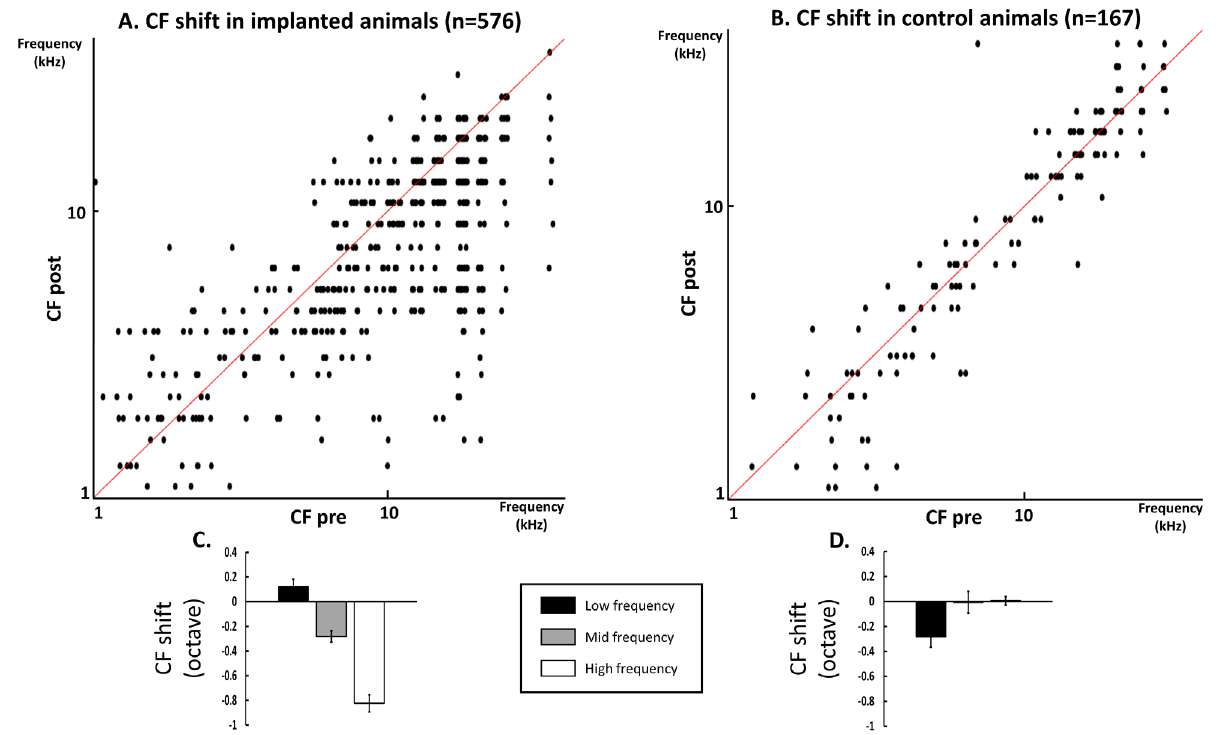
Figure 2. Quantification of the shift in CF values in the cochlear implanted animals ( A , C ) and in the control animals ( B , D ). A. Scattergrams representing the CF values obtained before cochlear implant insertion (abscissa) versus the CF values obtained after cochlear implant insertion (ordinates). Note that in a large majority of the cases, the CF values were lower after cochlear implant insertion (dots below the diagonal line). ( B ) Scattergrams representing the CF values obtained at the first placement of the cortical matrix of electrodes (abscissa) versus the CF values obtained at the second placement of the cortical matrix of electrodes (ordinates). Note that in a large majority of the cases, the CF values were quite similar (dots on or around the diagonal line). ( C ) Quantification of the mean CF shift ( ± sem) in the implanted animals in the low (0.95–3.8 kHz), middle (4.5–10.7 kHz) and high (12.7–36 kHz) frequency ranges. On average, the changes were 0.15 ± 0.10 octaves in the low frequencies, − 0.40 ± 0.06 octaves in the middle frequencies, and − 0.79 ± 0.06 octaves in the high frequencies (negative values indicate lower CF after CI insertion). ( D ) Quantification of the mean CF shift ( ± sem) in the control animals in the low (0.95–3.8 kHz), middle (4.5–10.7 kHz), and high (12.7–36 kHz) frequency ranges. On average, the change in CF values was − 0.28 ± 0.08 octaves in the low frequencies, 0.004 ± 0.07 in the middle frequencies, and − 0.002 ± 0.03 octave in the high